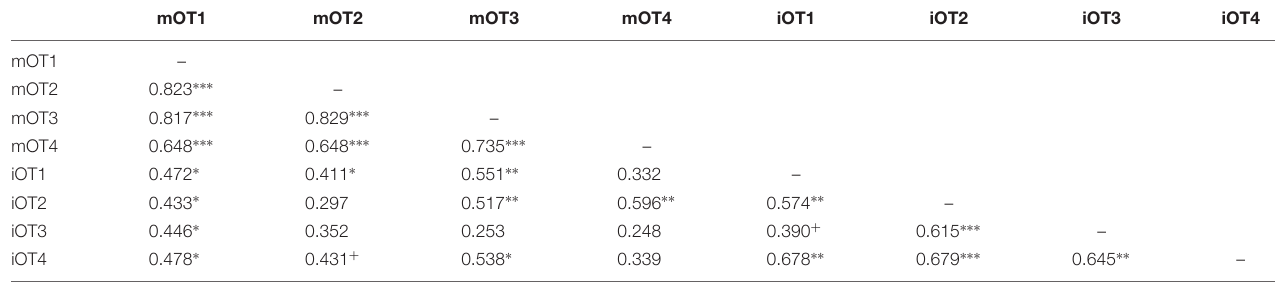
TABLE 5A | Bivariate relations between maternal and infant baseline OT at the four time points (original data). mOT1 mOT2 mOT3 mOT4 iOT1 iOT2 iOT3 iOT4